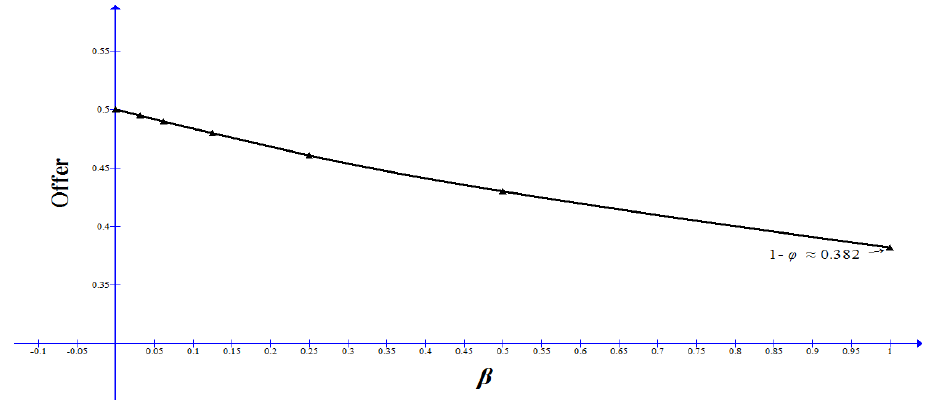
Figure 2. The predicted offer as a function of the ratio between the risk indices of the proposer and responder.